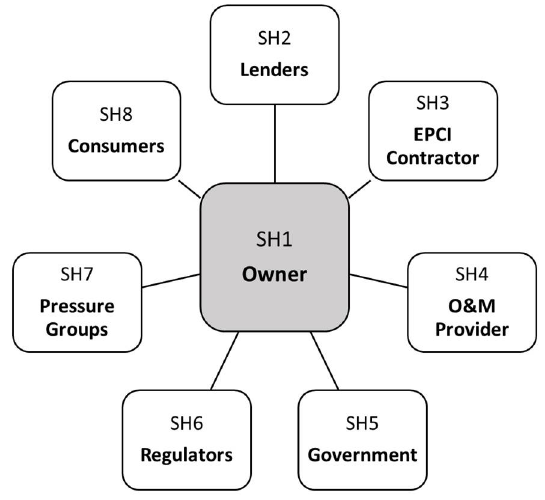
Figure 5. Wave energy stakeholder groups.